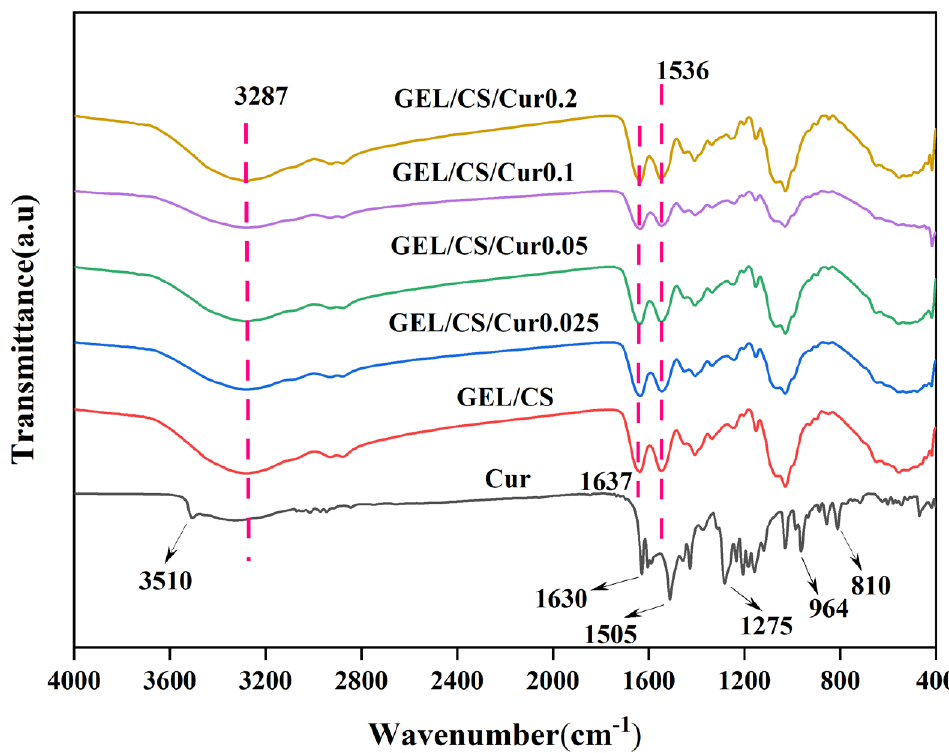
Figure 4. Fourier–transform infrared (FTIR) spectra of GEL/CS and GEL/CS/Cur composite films.